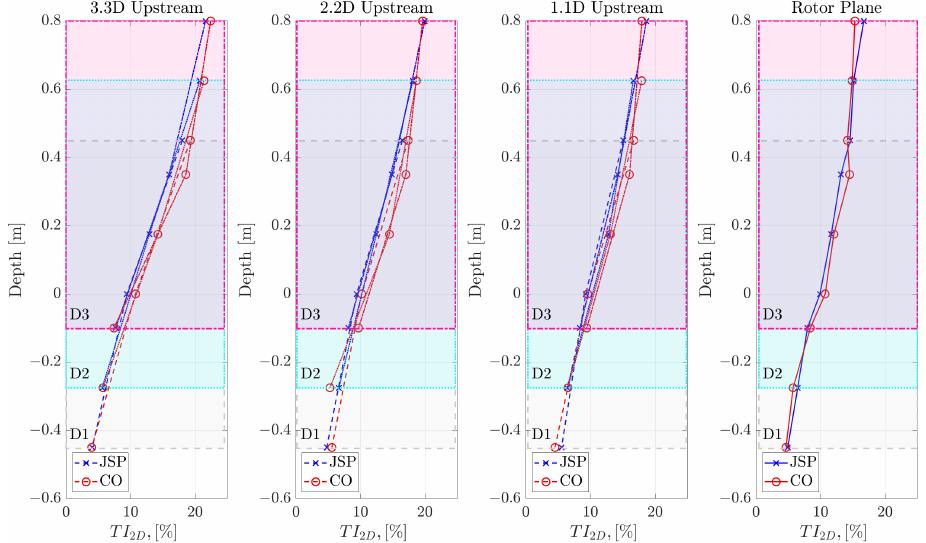
Figure 5. Mean 2-D TI against depth. Each chart presents the results for differing LDV positions; shaded regions highlight the turbine rotor span at each of the depths tested—D1, D2 and